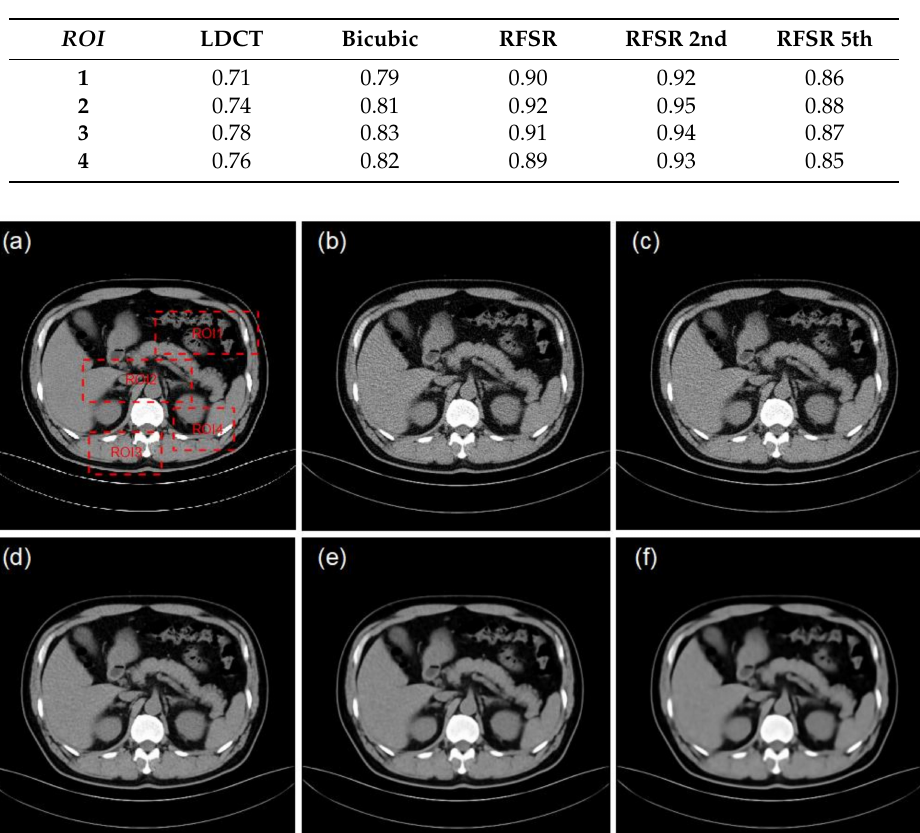
Table 5. The SSIM value of the four ROIs marked by red squares in Figure 5a.